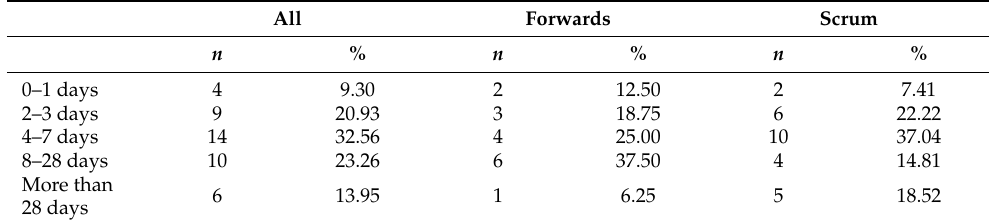
Table 1. Period out of sport practice for injured players.